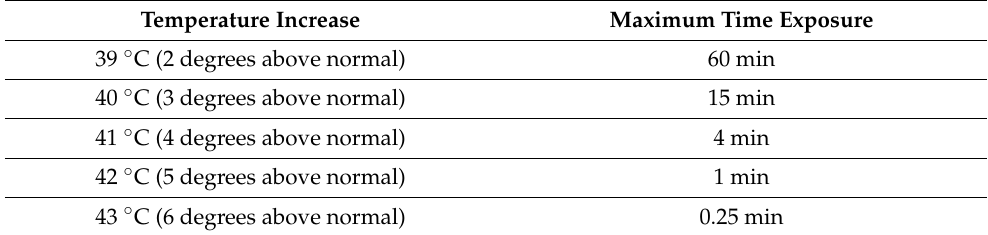
Table 7. Temperature level limits [86].